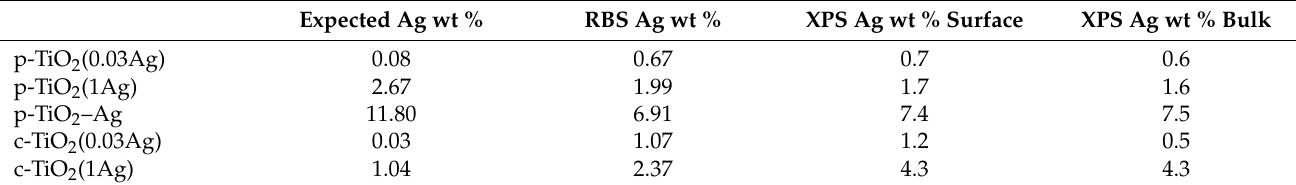
Table 2. Expected silver content of the samples and determined by RBS and XPS measurements. The RBS silver content values for c TiO 2 (0.03Ag) and c-TiO 2 (1Ag) samples are taken from our previous publication [31]. Expected Ag wt % RBS Ag wt % XPS Ag wt % Surface XPS Ag wt % Bulk p-TiO 2 (0.03Ag) 0.08 0.67 0.7 0.6 p-TiO 2 (1Ag) 2.67 1.99 1.6 p-TiO 2 –Ag 11.80 6.91 c-TiO 2 (0.03Ag) 0.03 0.5 c-TiO 2 (1Ag) 1.04 2.37 4.3